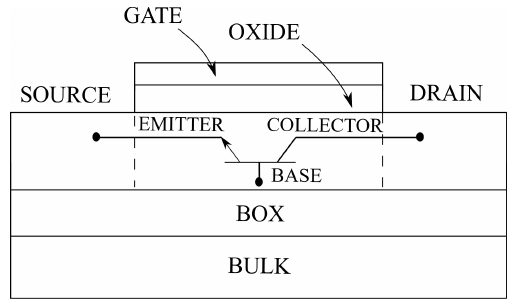
Figure 12. Parasitic bipolar junction transistor (BJT) in single gate junctionless transistor.